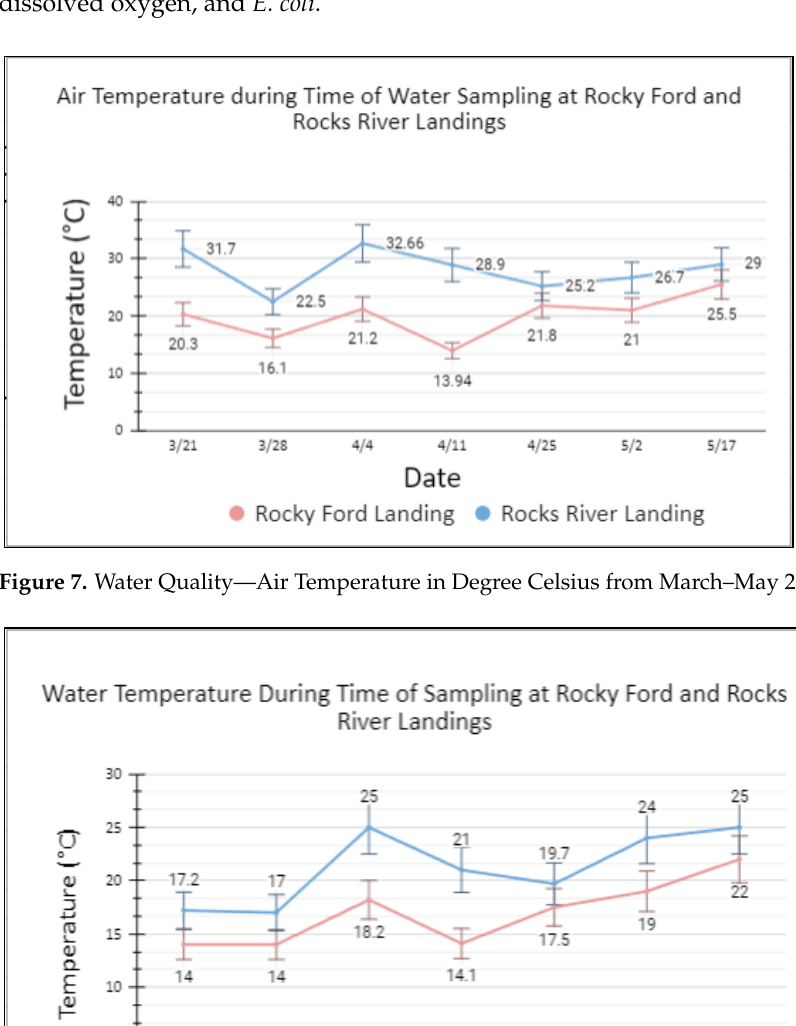
Figure 9. Water Quality — pH Level Measurements from March – May 2022.